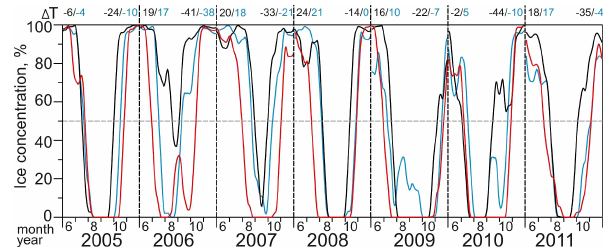
Figure 12. Observed June–November time series of sea ice con- centration (%) at three locations along 81 ◦ N depicted with crosses in Figs. 8 and 12a: 68 ◦ E (black), 73 ◦ E – mooring position (red), and 78 ◦ E (blue). Black/blue numbers at the top show the time lag ( 1T , days) between 73 ◦ E and 68/78 ◦ E on reaching the 50% sea ice